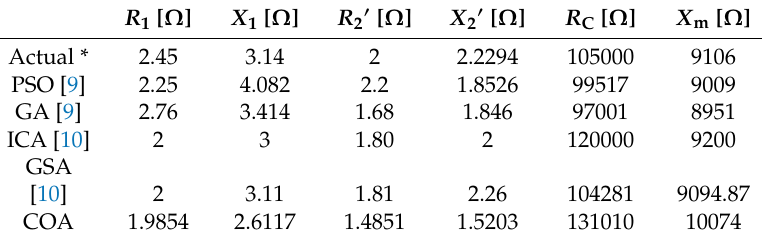
Table 2. Parameter values for 15kVA transformer from [9,10].